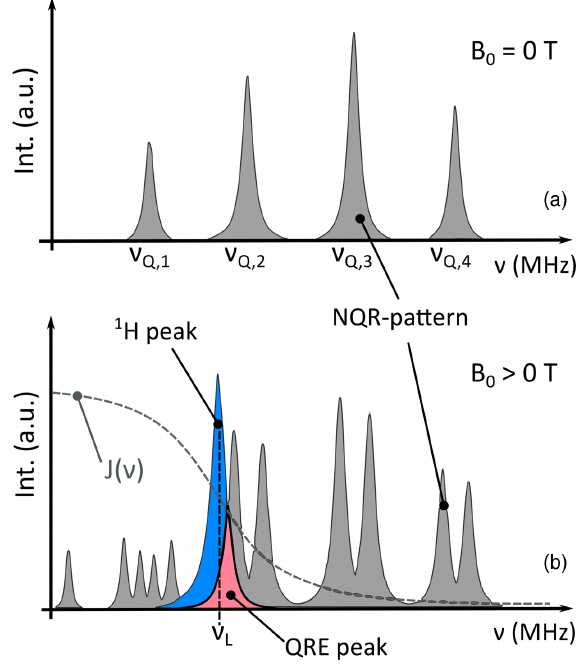
FIG. 1. Simple scheme of transition frequency crossing to produce QRE in protons. For illustration and simplicity, the line shapes are assumed to be Lorentzian [see Appendix B, Eq. (B3)] with equal width for each transition. Intensities in a.u. correspond to Boltzmann weighted transition probabilities [Appendix A, Eq. (A8)]. In panel (a), the pure NQR pattern of a single crystal is shown (grey pattern). In panel (b), B 0 > 0 T leads to an observable 1 H resonance (blue peak) at the Larmor frequency ν L , as well as to a splitting of the NQR pattern [Appendix A, Eq. (A7)]. The four-line splitting of the lowest transition is a consequence of nonzero off-diagonal elements of the Hamilto- nian [30]. A transition frequency match at a particular field strength B 0 — indicated by the red highlighted overlap area — and the D-D fluctuations J ð ν Þ at the corresponding frequency, are the main conditions for a QRE of the